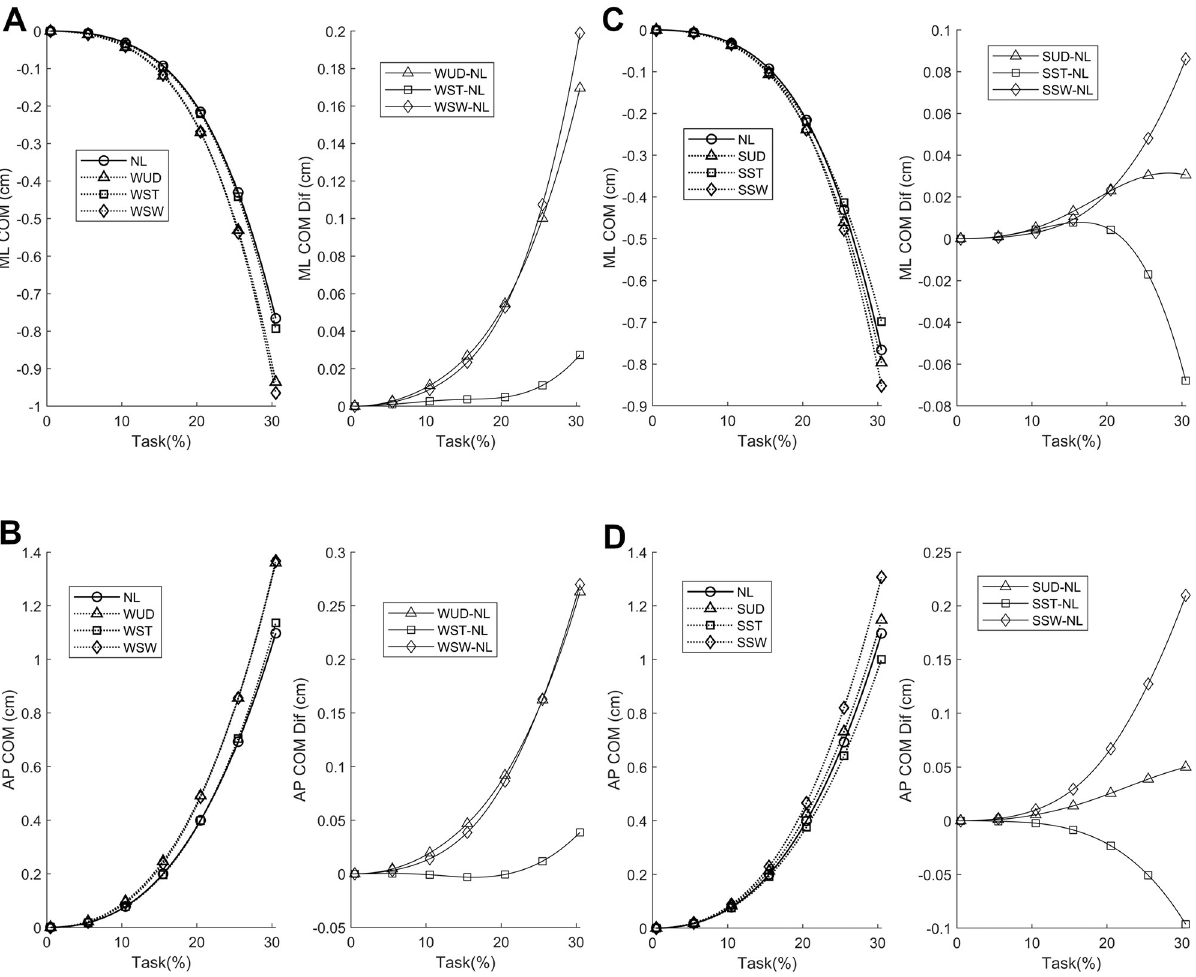
Fig 3. Average medial-lateral (ML) and anterior-posterior (AP) center of mass (COM) anticipatory postural adjustments (APA) phase components, with additional weight positioned at the waist (A and B, respectively) and shoulder (C and D, respectively) and their corresponding differences compared to the no-load (NL) condition. WUD: weight uniformly distributed at the waist; WST: weight positioned at the waist on the stance foot side; WSW: weight positioned at the waist on the swing foot side, SUD: weight uniformly distributed at the shoulder; SST: weight positioned at the shoulder on the stance foot side; SSW: weight positioned at the shoulder on the swing foot side.